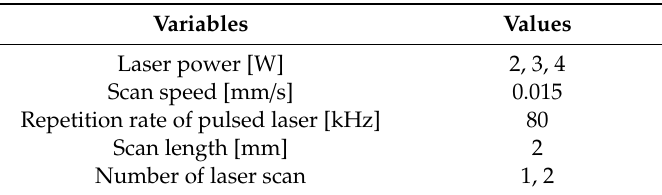
Table 2. Laser parameters for LCLD.